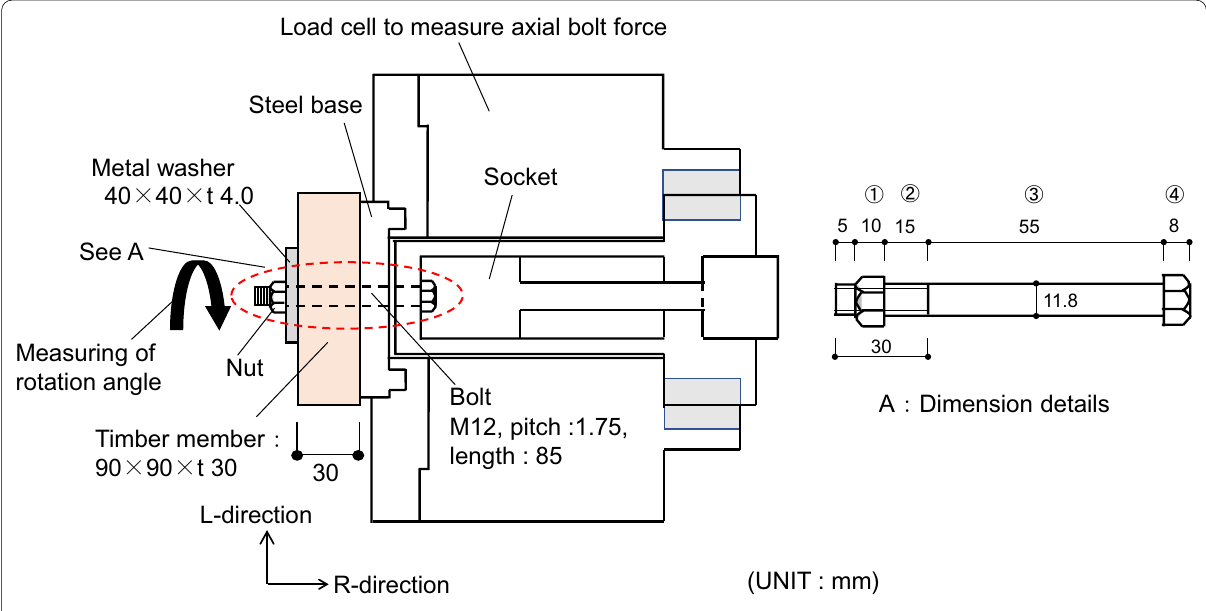
Fig. 2 Tightening test method ( L longitudinal, R radial)